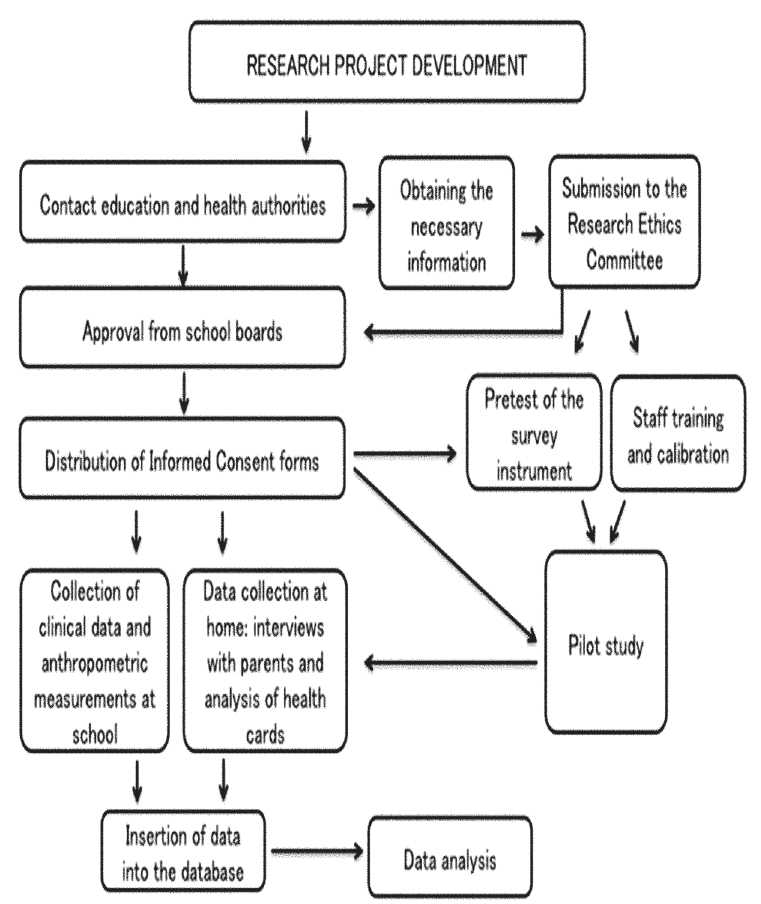
Figure 1 - Synthesis of the methodological